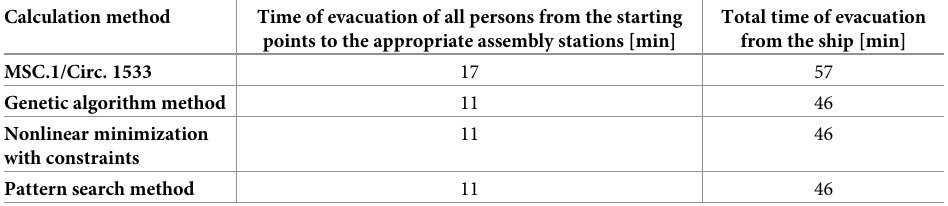
Table 1. Calculation results of the evacuation time of a passenger ship. Calculation